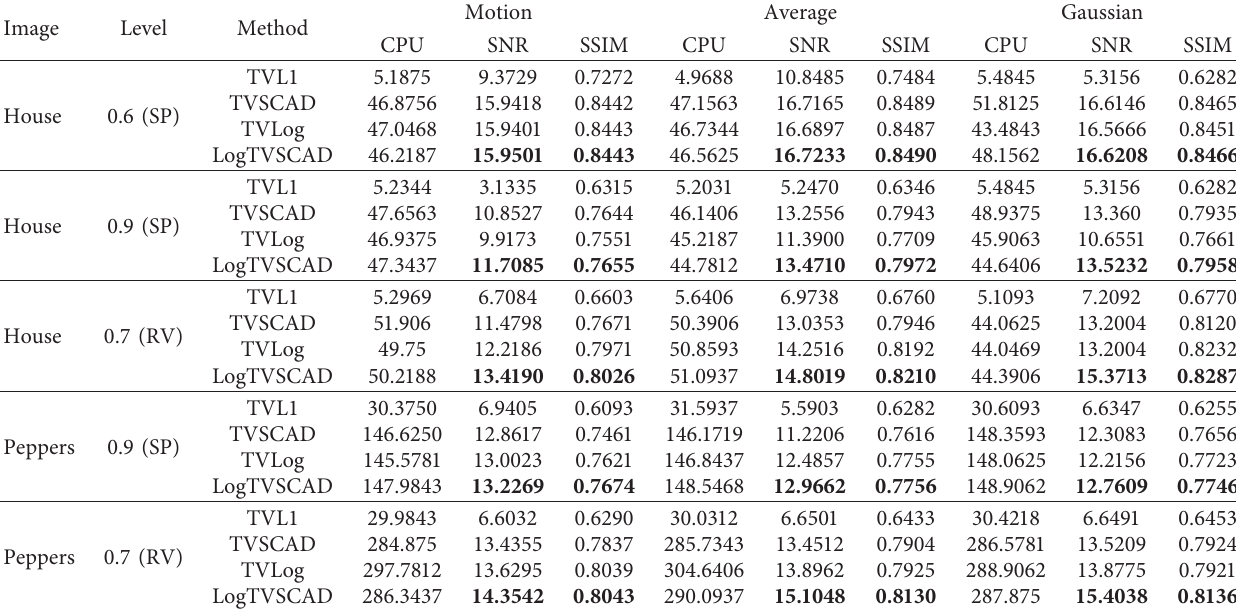
Figure 16: The recovery results (Peppers 512) by Average blur with 70% RV noise. (a) Original. (b) TVL1, PSNR � 19.1807. (c) TVSCAD, Table 1: Performance comparison of different methods for SP and